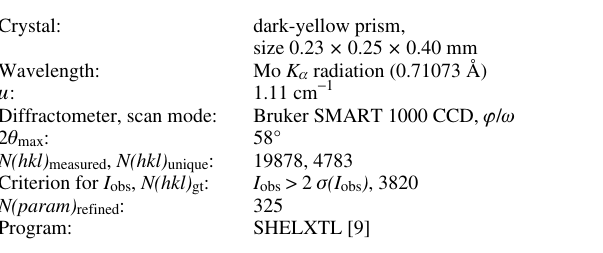
Table 1. Data collection and